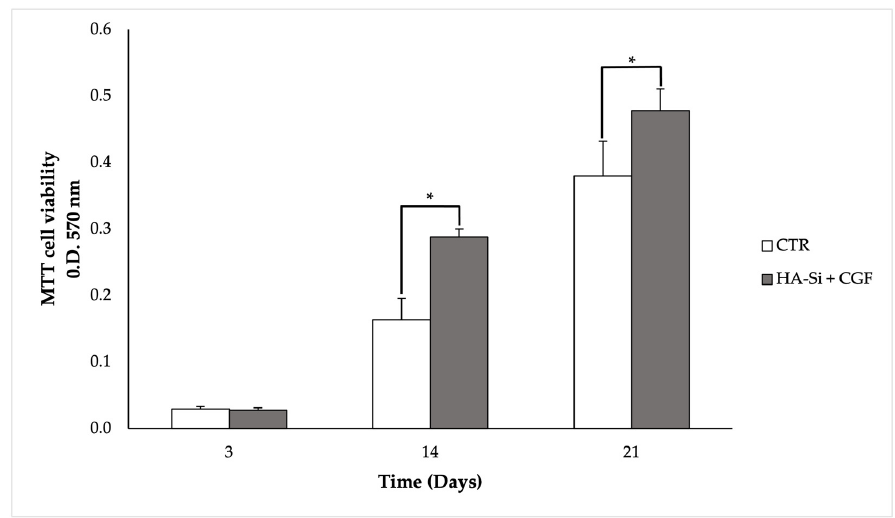
Figure 3. Proliferation and viability analysis of CGF primary cells cultured on HA-Si scaffold by MTT assay after 3, 14, and 21 days from seeding. CGF primary cells released directly on the plate were used as a control. Data are represented as mean ± SD of triplicate measurements from three independent experiments. * p < 0.05 compared to CTR, using Student’s t - test.